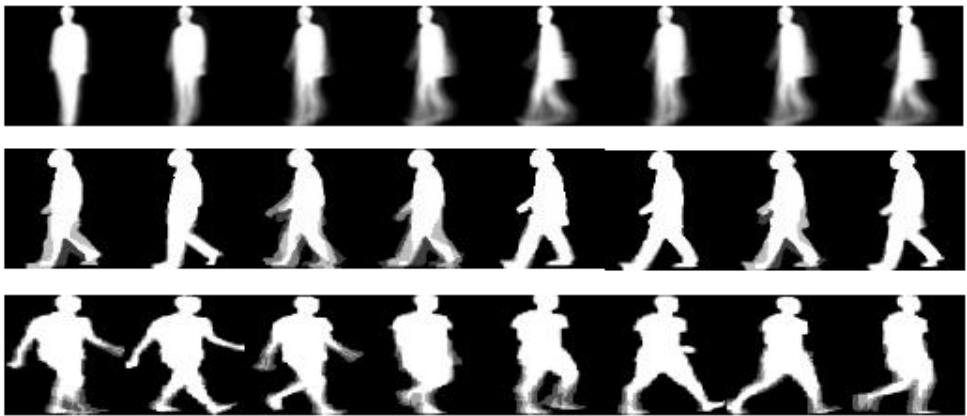
Figure 2. Instances of acquired GEIs, first row: CASIA-B, second row: OU-ISIR D, and last row: